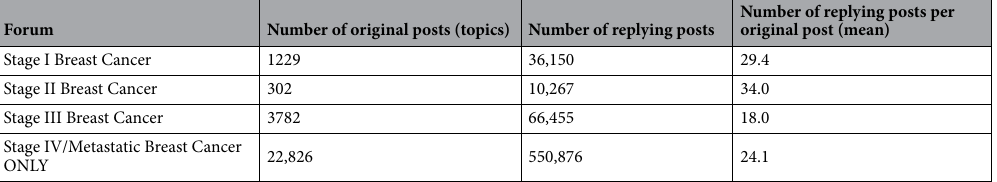
Table 1. Number of posts in each forum.